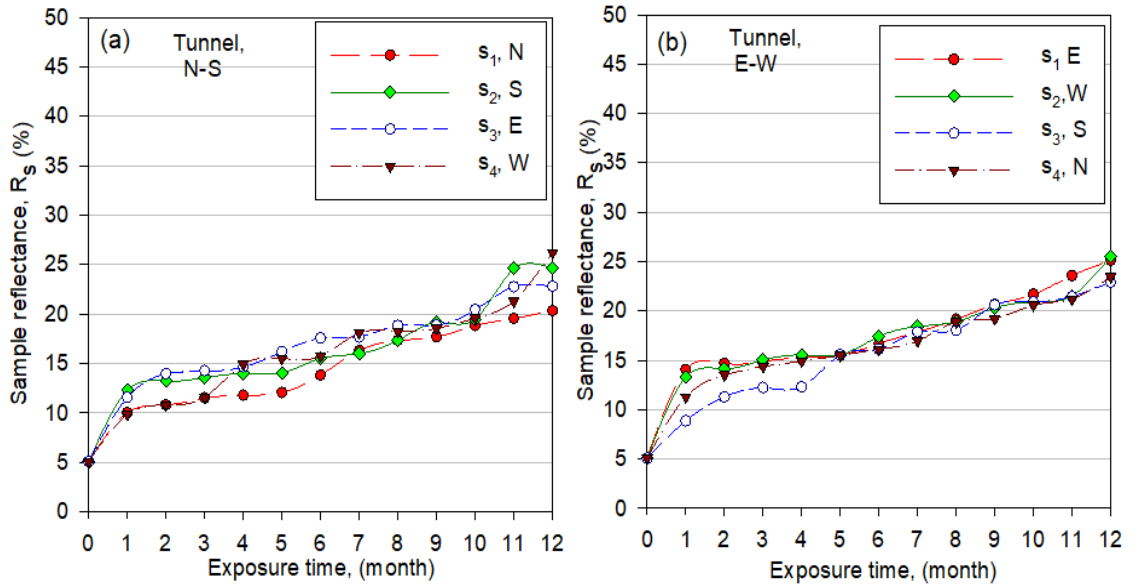
Figure 5. Variation of the sample reflectances ( R s ) affected by the exposure time for the tunnel prototype cover oriented in the N–S ( a ) and E–W ( b ) directions under arid climatic conditions.